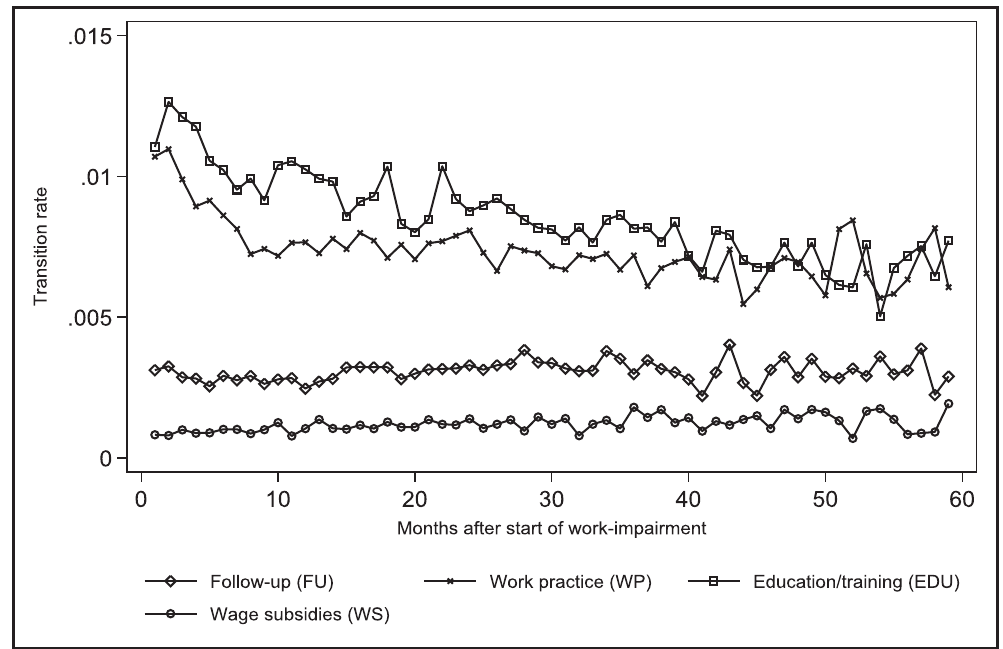
Figure 3 Monthly transition rates into vocational rehabilitation programs (VRPs). Young people 18-29 years of age in the period 2002–2012.